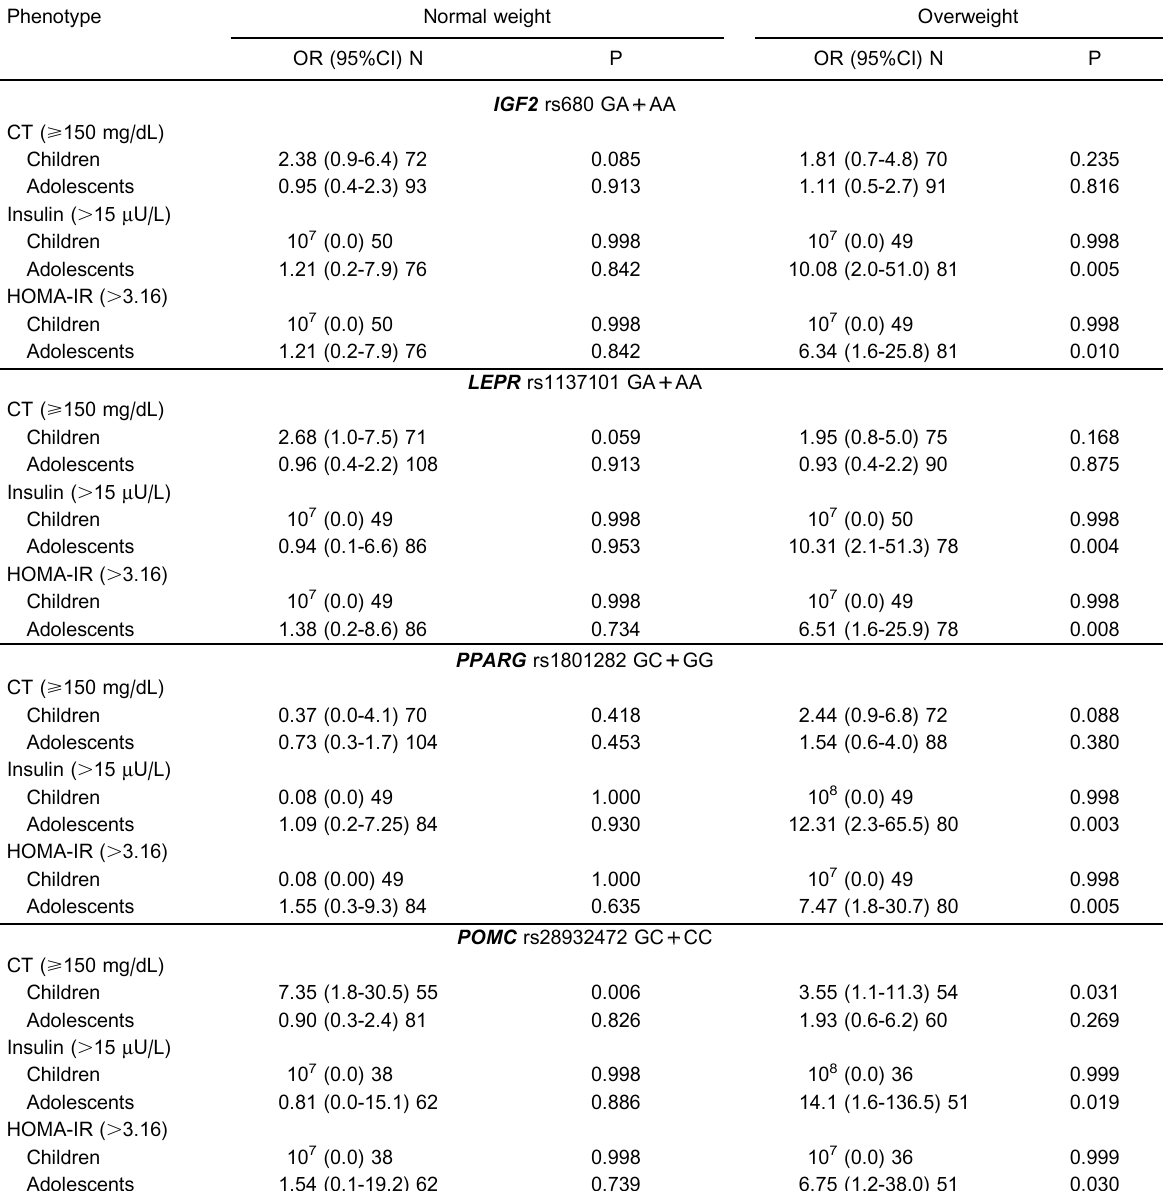
Table 4. Summary of odds ratio and 95% confidence intervals for selected phenotypes of the SNPs studied in the dominant model. Phenotype